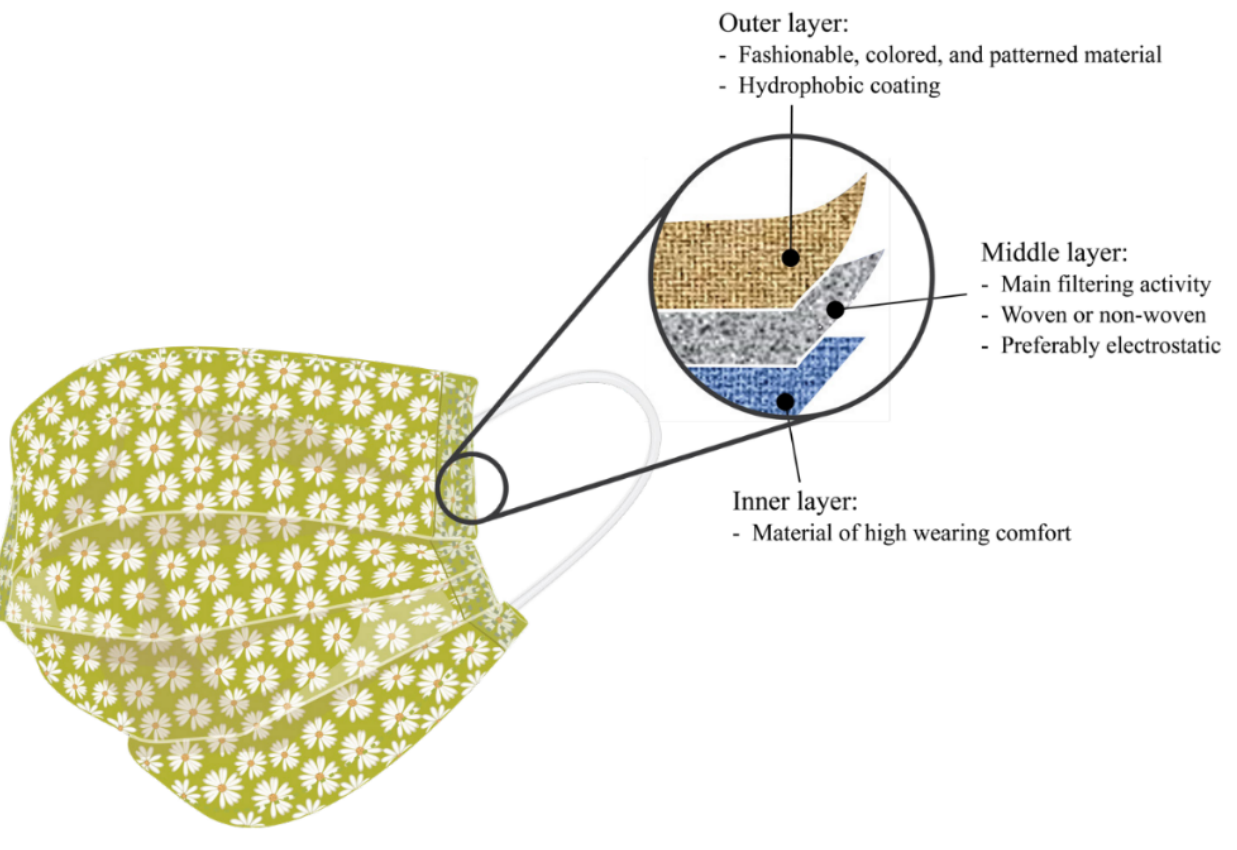
Figure 7. Cloth masks material features [88].